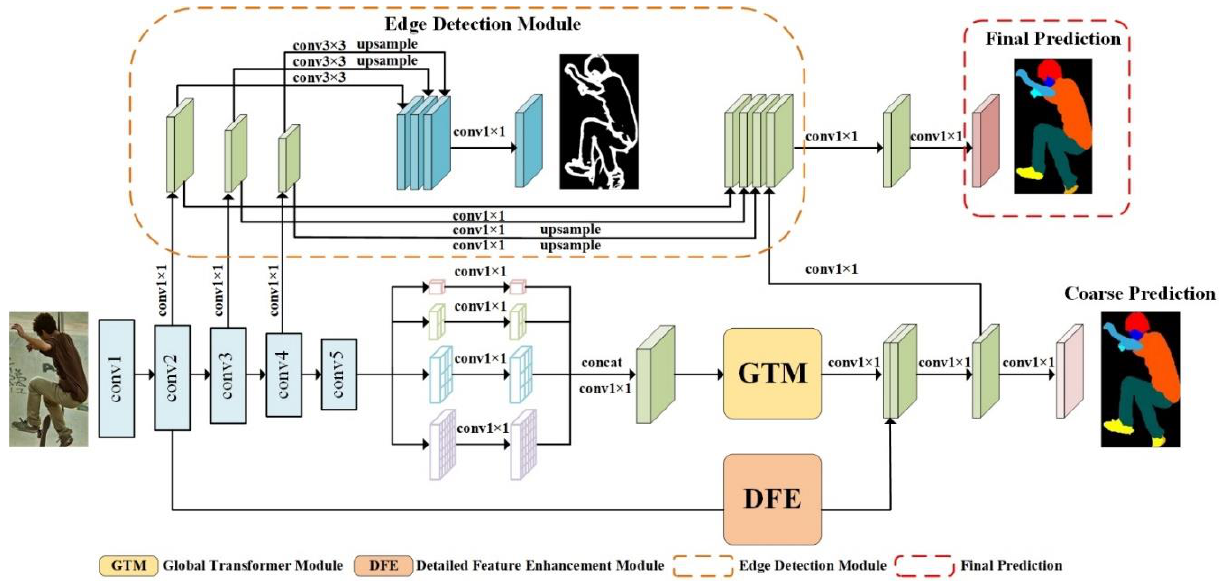
Figure 2. The pipeline of our framework. GTM: Global Transformer Module. DFE: Detailed Feature Enhancement Module.